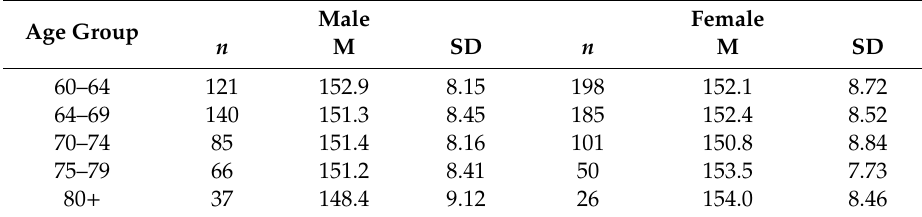
Table 2. Height based on age group and gender, Unit: cm.